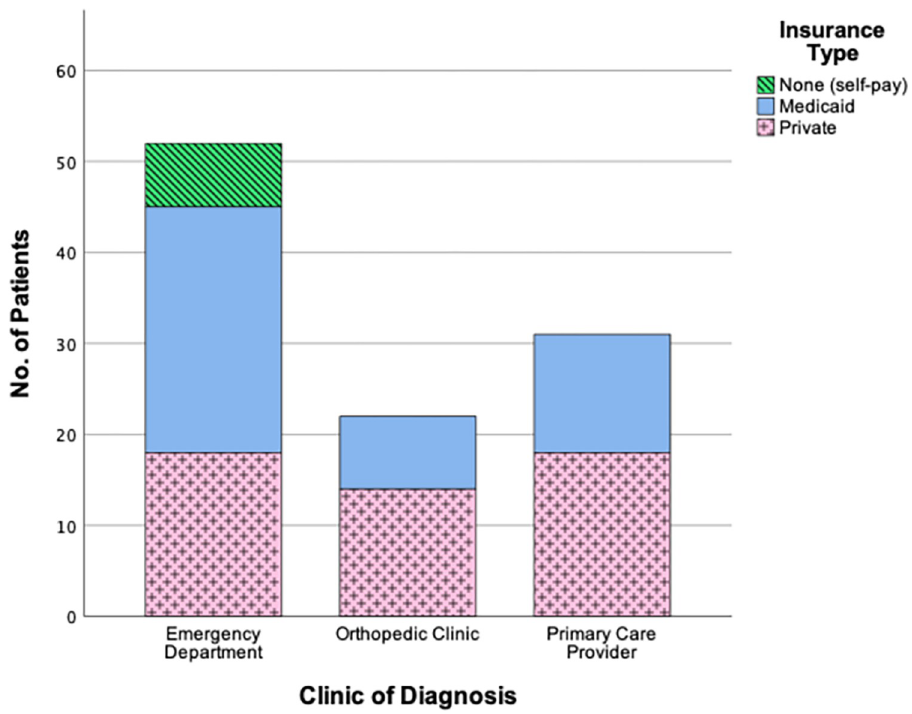
Fig 2. Clinic of diagnosis for patients with each insurance